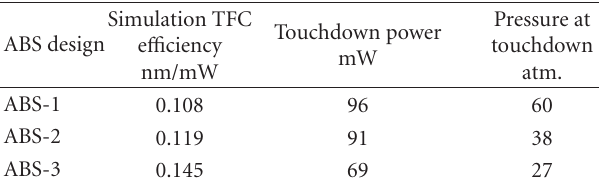
Table 1: Simulated results for the three di ff erent ABS designs. designSimulation TFC ABS e ffi